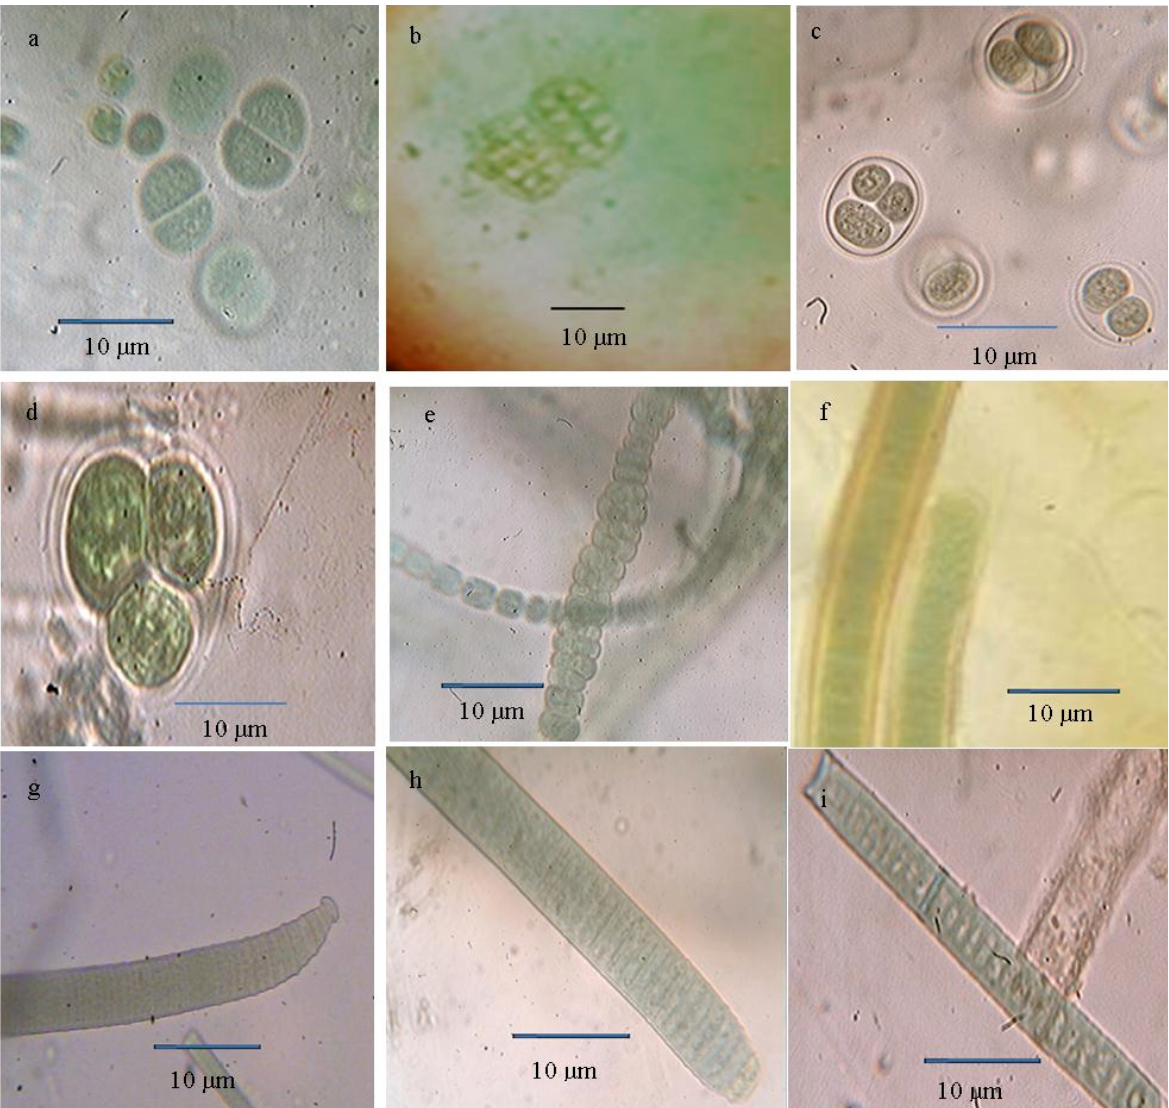
Table 3. Numerical analysis for fertility category of soil samples from Patan Tehsil, Satara District. pH EC Fertility status No. of soil samples showing